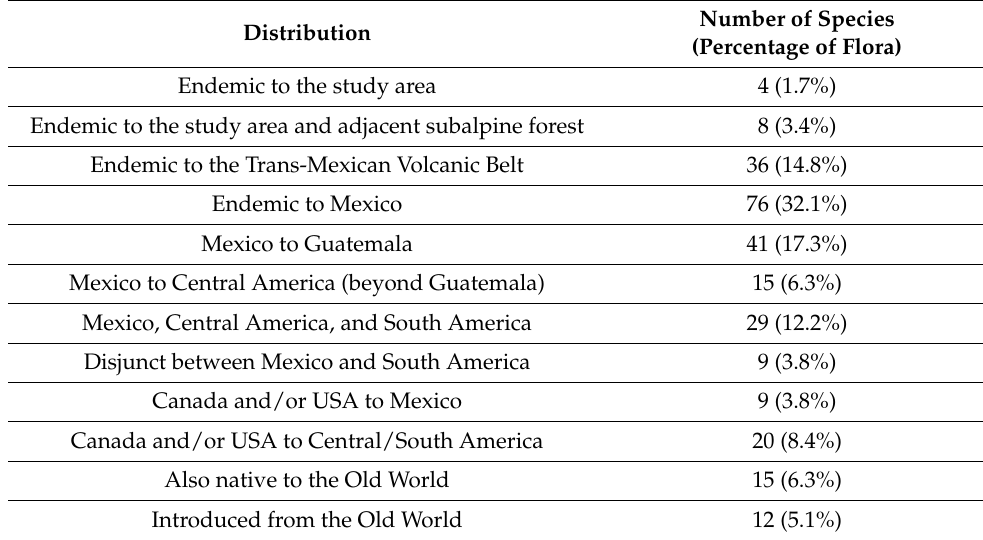
Table 2. Phytogeographic summary of the species.